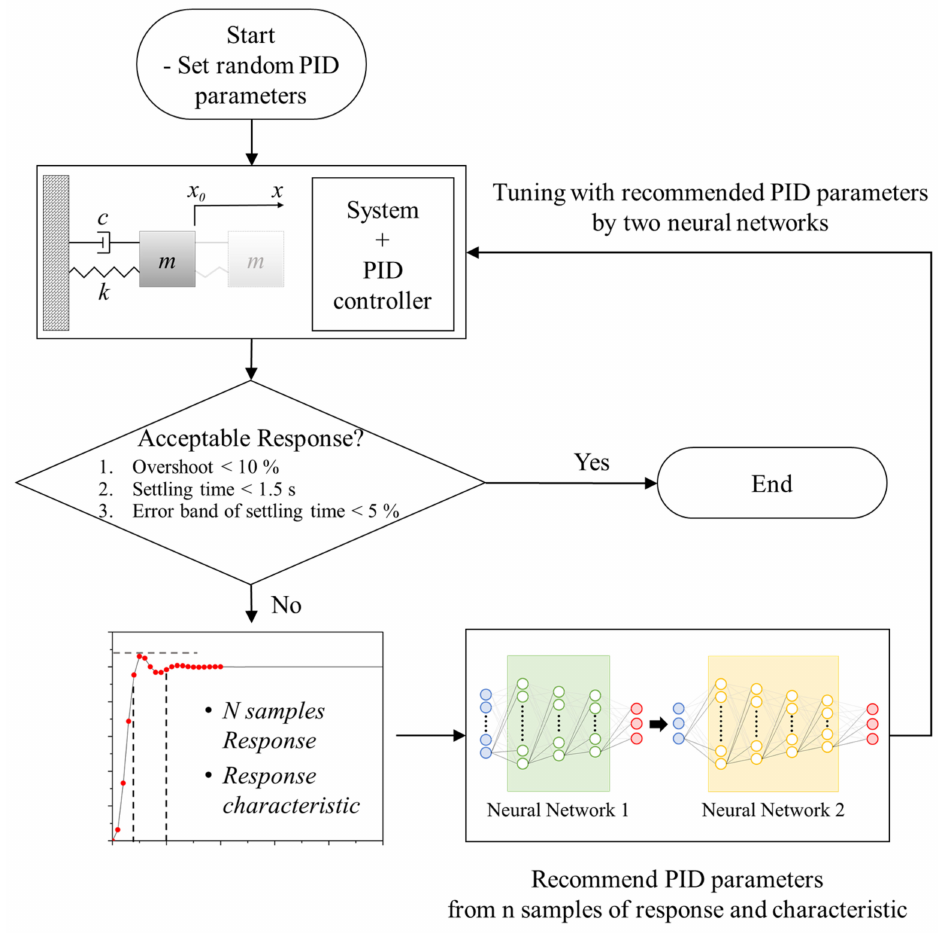
Figure 5. Flowchart of the tuning process using neural